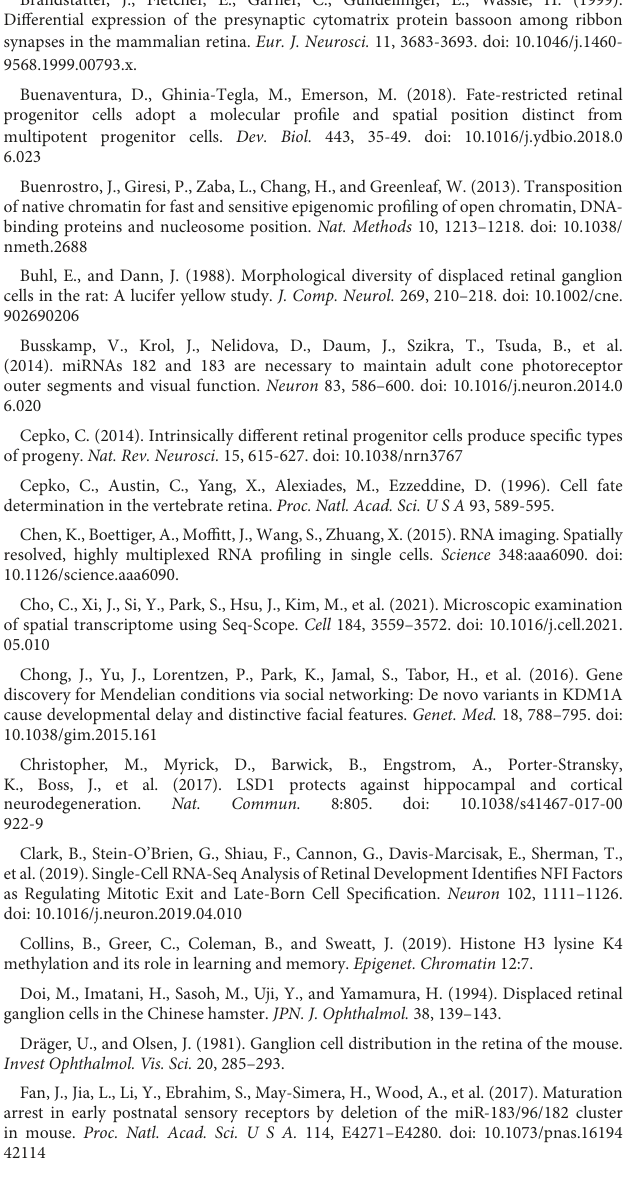
between the two groups (D) . Two-Way ANOVA with Tukey’s multiple comparisons test. Samples sizes: Lsd1 fl / fl ( n = 7), Rho-iCre75 Lsd1 fl / fl ( n = 7). SUPPLEMENTARYFIGURE4 Rho-iCre75 Lsd1 fl / fl animals show no obvious in vivo morphological differences compared to controls. In both fundus photos (A,B) and SD-OCT Rho-iCre75 Lsd1 fl / fl ( n = 5).